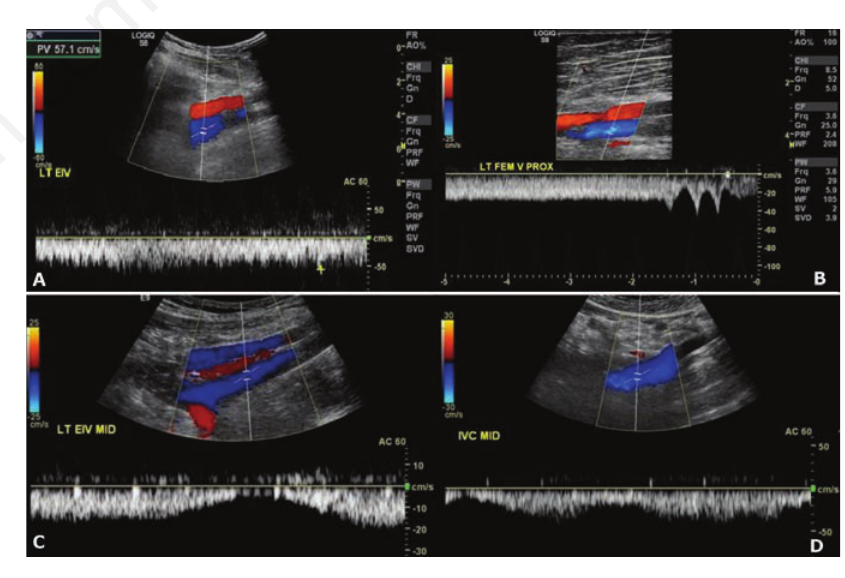
Figure 2. A) Color duplex showing evidence of flow inside the left external iliac artery (red) and left external iliac vein (blue). Absence of respiratory variations in venous wave- forms suggests a proximal obstruction; B) Absence of respiratory variations in venous wave-form of the left femoral vein suggests a proximal obstruction. C) Color duplex after Figure 1. Abdominal radiograph showing fecal disimpaction with normal venous waveforms in left external iliac vein and D) infe- fecal impaction. rior vena